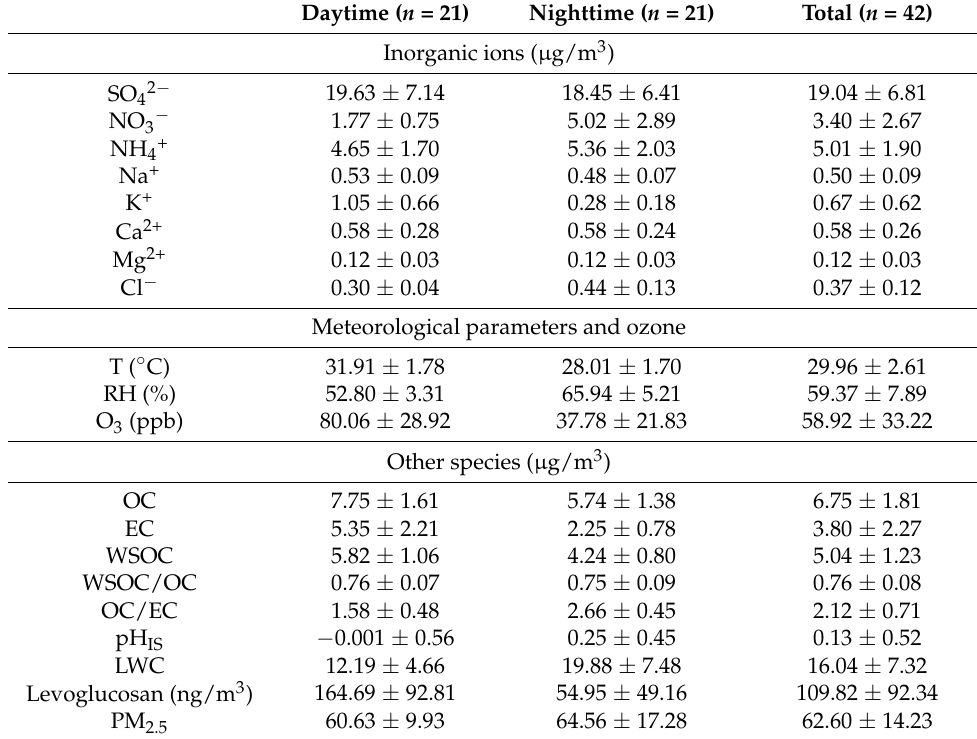
Table 1. Meteorological conditions, PM 2.5 , and chemical component mass concentration during the sampling